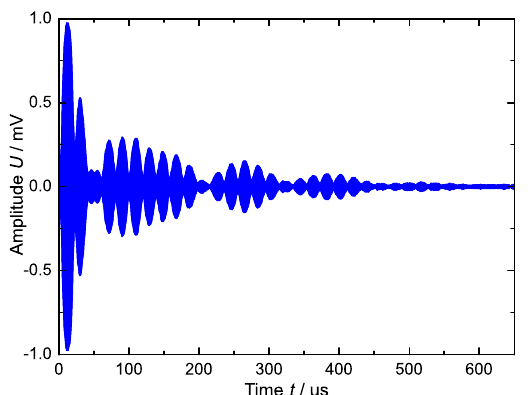
Figure 11. Modulation of the carrier frequency by the free induction decay (FID) signal in GaSe after pulse excitation (duration τ = 3 us, power P = 200 W, bandpass filter bandwidth Δ F = 25 MHz, blanking time τ BL ~300 ns).